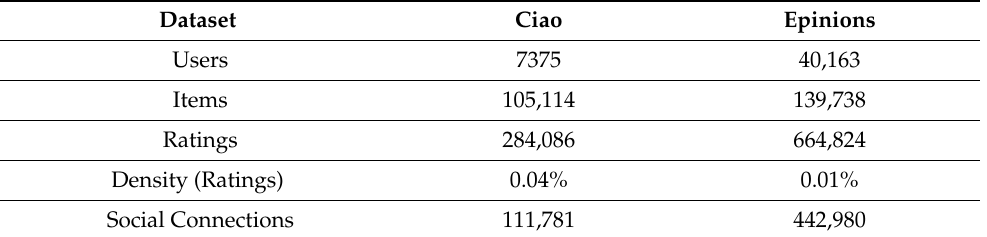
Table 1. Statistics of the